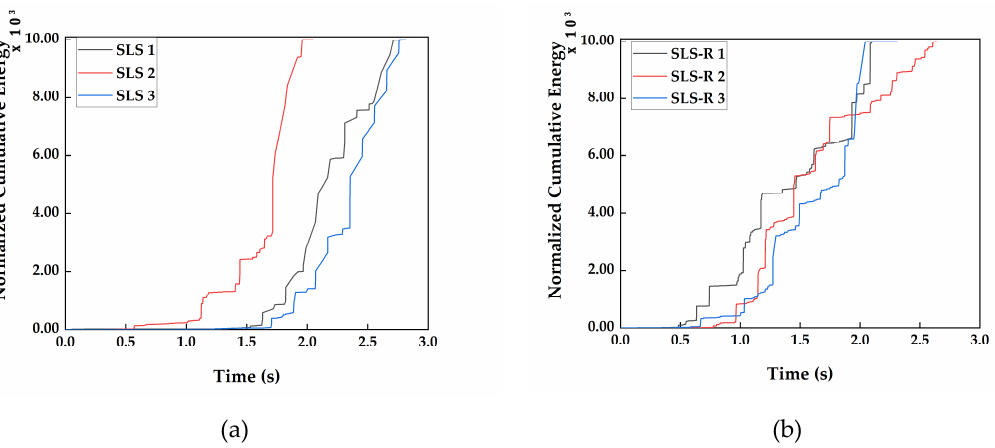
Figure 6. Normalized Cumulative Energy recorded for ( a ) SLS group of specimens, ( b ) SLS-R group of specimens.